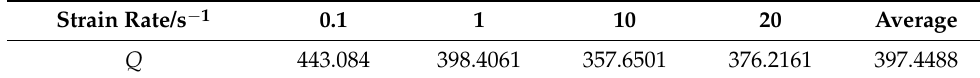
Table 3. The values of Q under different deformation rates.